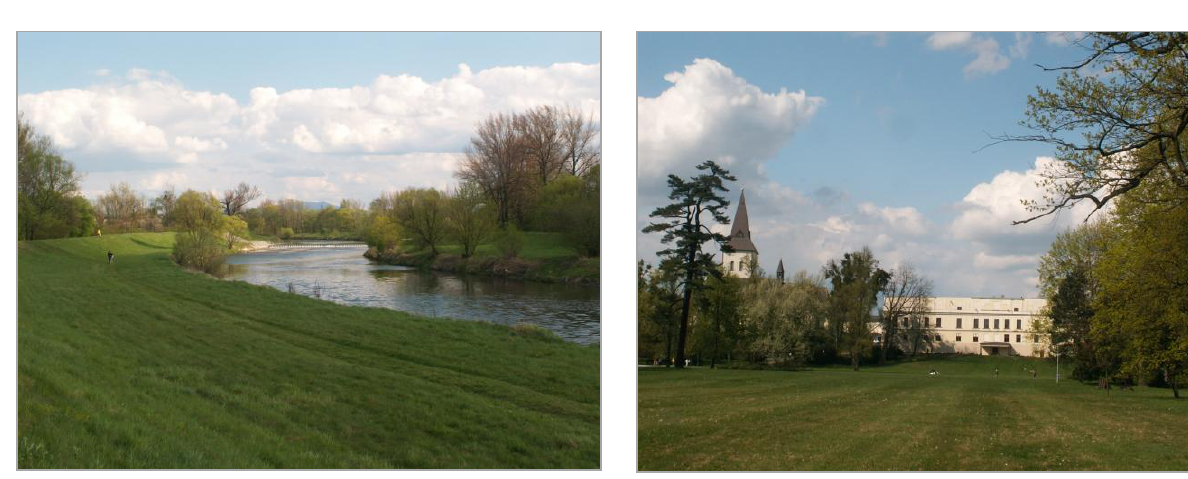
Fig. 7. Attractive cycling path along the Olše River in the face working area of Karviná – Darkov ( J. Havrlant , 2014)